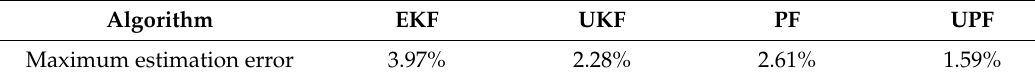
Figure 13. Estimation error curves of different algorithms at 25 °C.